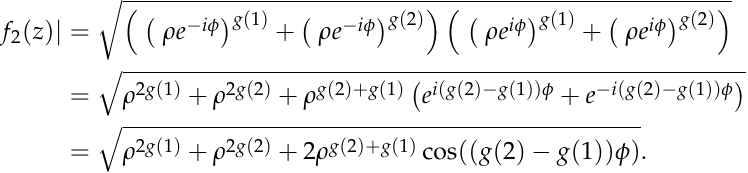
( k ) produces a host of additional subsets, 16